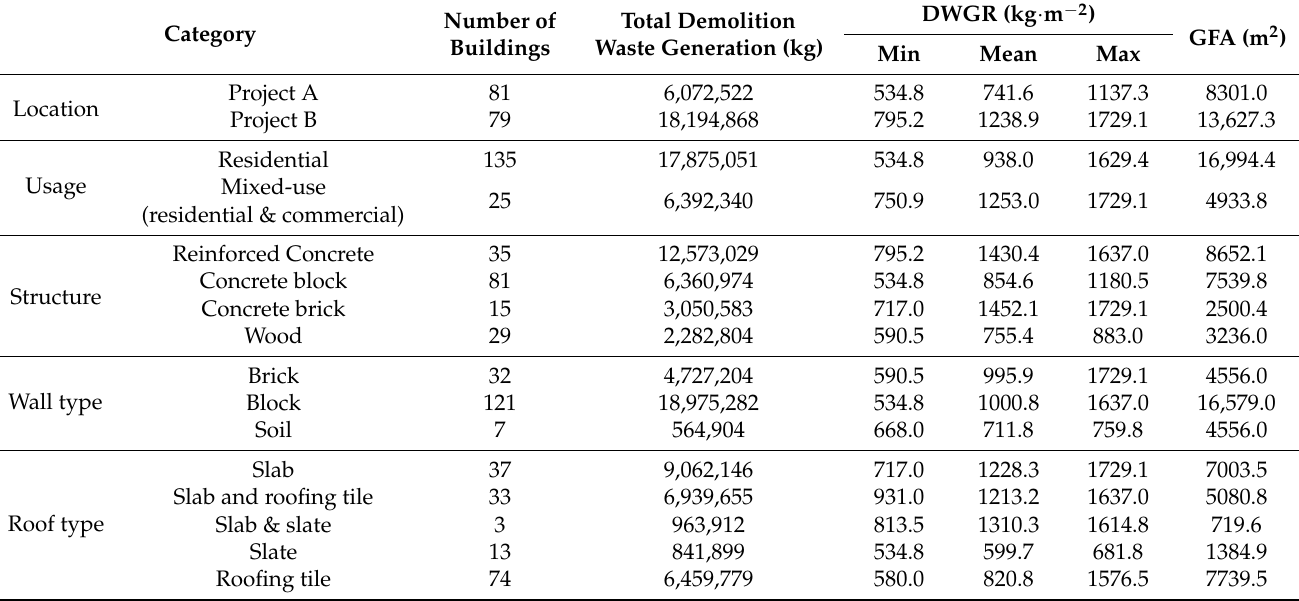
Table 1. Building description and statistical summary of the variables